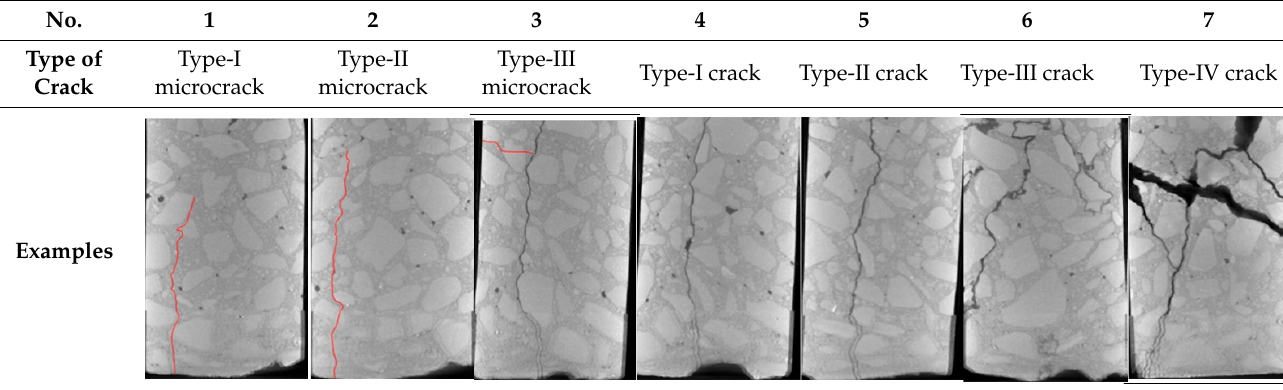
Table 3. Examples of particular types of cracks [126].